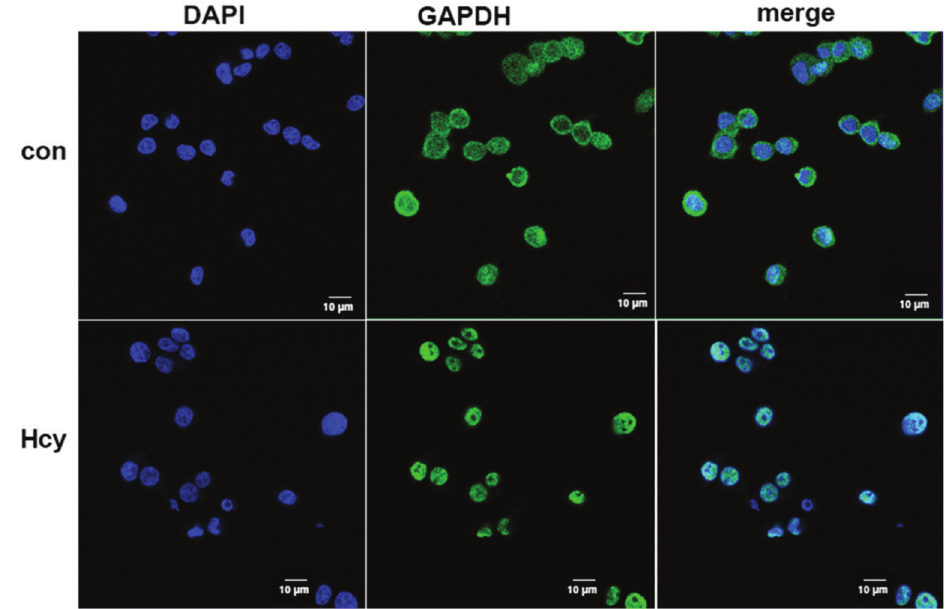
Figure 3. Immuno fl uorescence of glyceraldehyde 3-phosphate dehydrogenase (GAPDH) cell location before and after homocysteine (Hcy) treatment. Neuro2a cells in the presence of 5 mM Hcy or absence (control [con]) of Hcy for 48 h were then fl uorescently labeled with a GAPDH-directed antibody and 4 0 ,6-diamidino-2-phenylindole (DAPI). Representative images of each fl uorescent channel and merged images are shown. Scale bar: 10 m m.